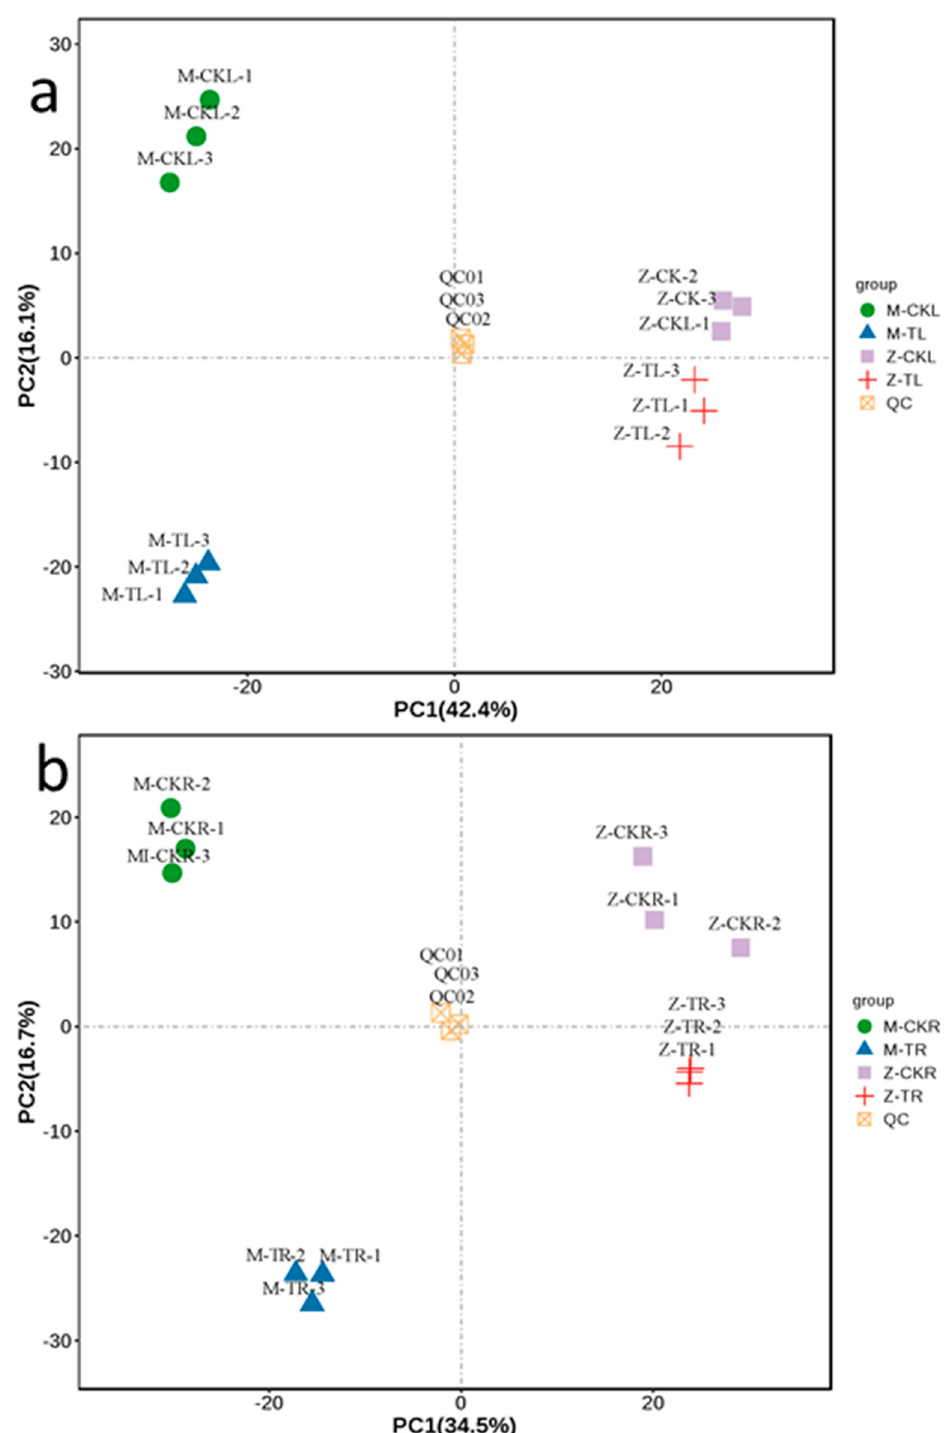
Figure 5. PCA of metabolites in leaves and roots in ZM-4 and M9T337 under salt stress. ( a ) PCA of metabolites in leaves in ZM-4 and M9T337 under salt stress. ( b ) PCA of metabolites in roots in ZM-4 and M9T337 under salt stress.